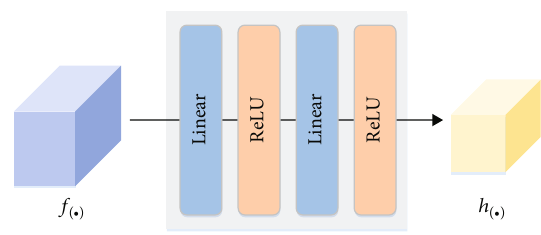
Figure 2: The pipeline of multilayer perceptron